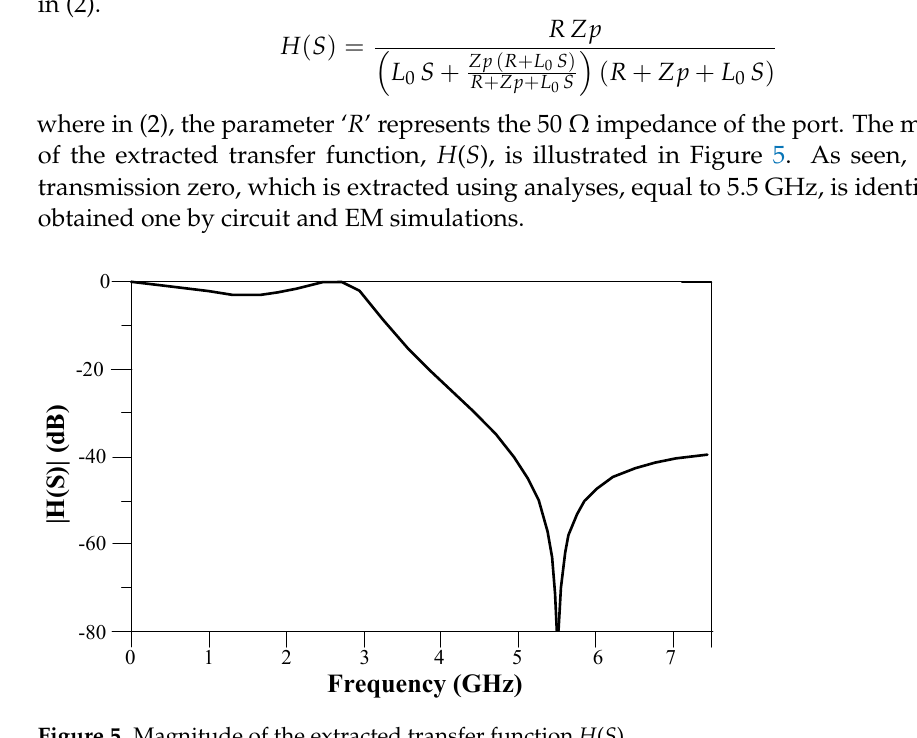
By obtaining the value of Z P , the transfer function of H ( S ) can be calculated as written in (2).